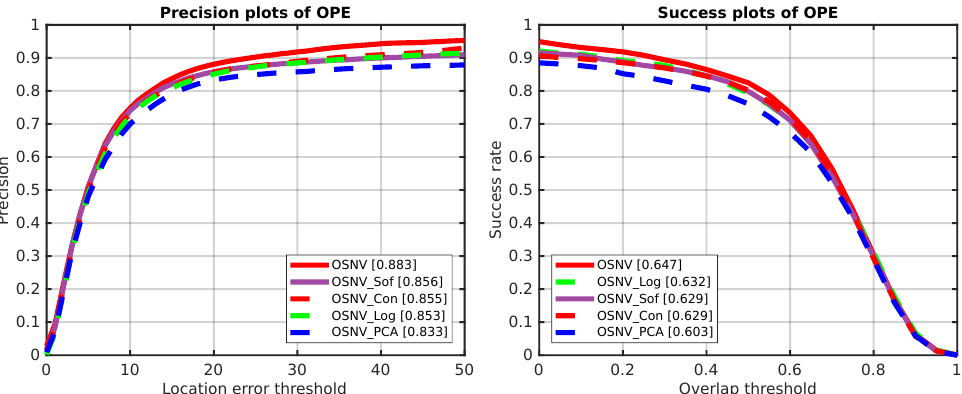
Figure 3. The ablation study results of OSNV on OTB-2013 with extra four algorithms. The plot on the left side is the precision amplitude varied with location error threshold, and the legend is about precision scores. The plot on the right side is the success plots of OPE on OTB-2013, best viewed in